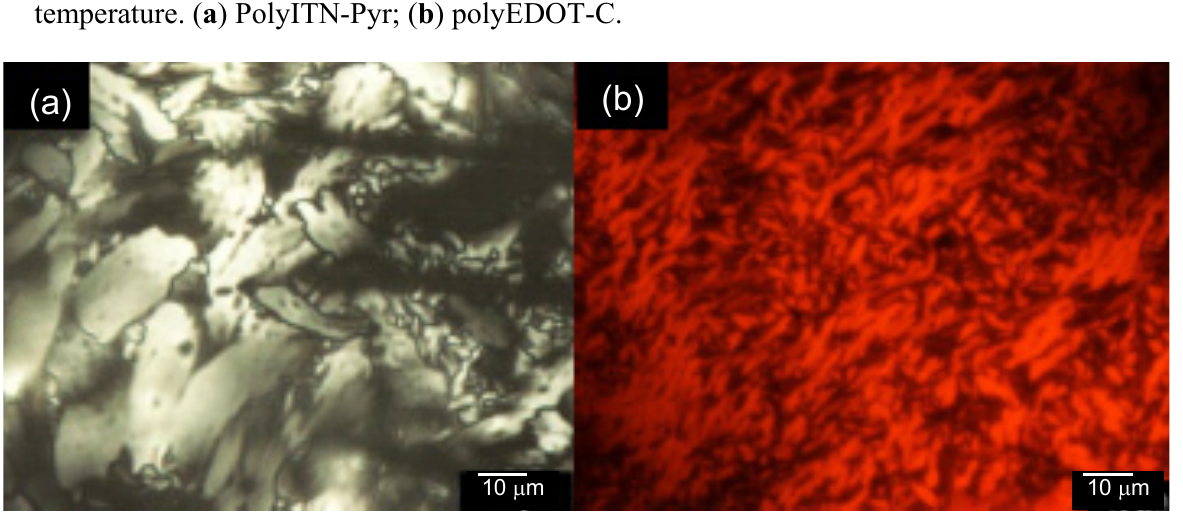
Figure 5. Polarizing optical microscopy (POM) images of PolyITN-Pyr at room temperature. The samples were first melted at 85 °C and gradually cooled to room temperature. ( a ) Insertion of a gypsum first-order red plate; ( b ) Structure resembling small